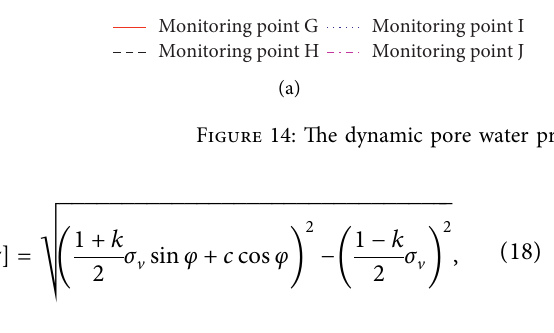
Simulation of underground water level determines the accuracy of test results. Test program of the simulation of groundwater level is shown in Figure 12.